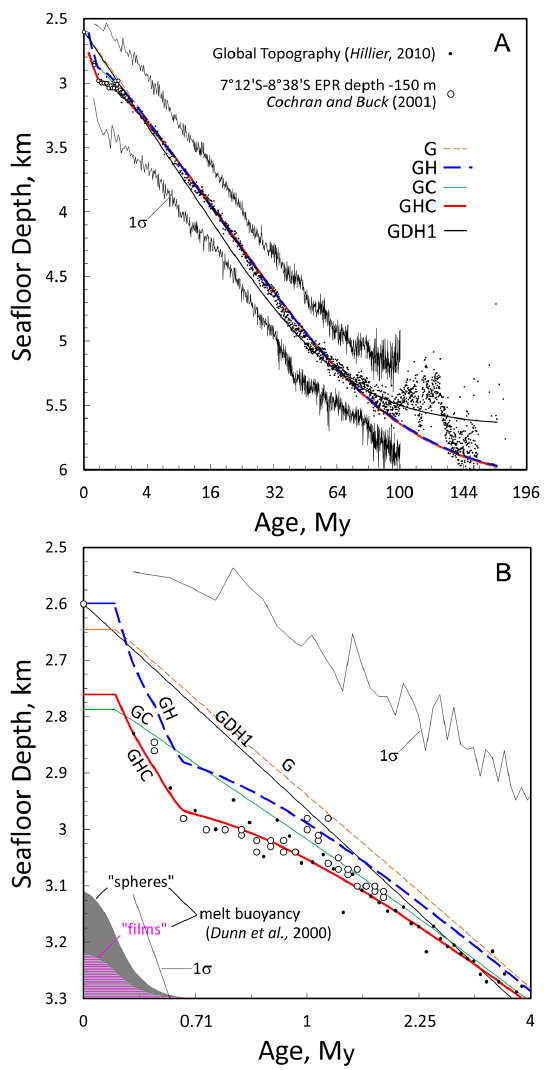
Figure 7. Predictions and observations of seafloor topography and subsidence on ridge flanks. (a) Seafloor topography of our mod- els compared with model GDH1 (Stein and Stein, 1992), 0.1My binned global “normal” depth data with 1 σ standard deviation from Hillier (2010), and EPR ridge depth data from Cochran and Buck (2001). (b) Close-up on the model predictions and observed topography on ridge flanks. In addition, the bottom left corner shows an additional cause of ridge elevation due to the buoyancy of melt beneath the ridge based on two models of seismic tomog- raphy from Dunn et al. (2000). For ages < 0 . 2My 1 / 2 there is no subsidence in our models since energy transfer is supported by la- tent heat release. Figure modified after Grose and Afonso